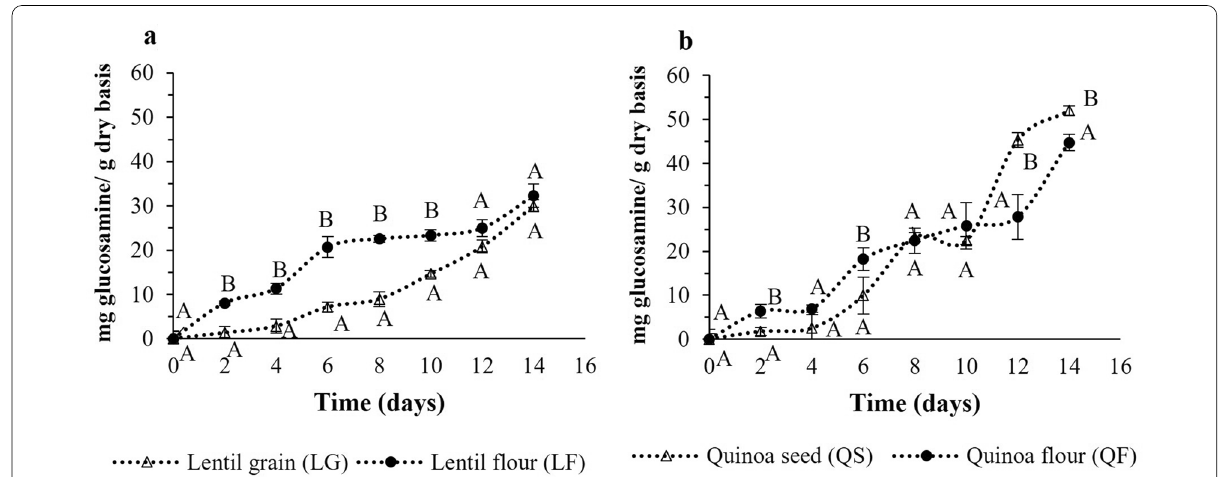
Fig. 1 Biomass production in lentil grain, quinoa seeds and respective flours at different fermentation times. AB Capital letters indicate significant differences between grain/seeds and flour at the 95% ( p < 0.05) significance